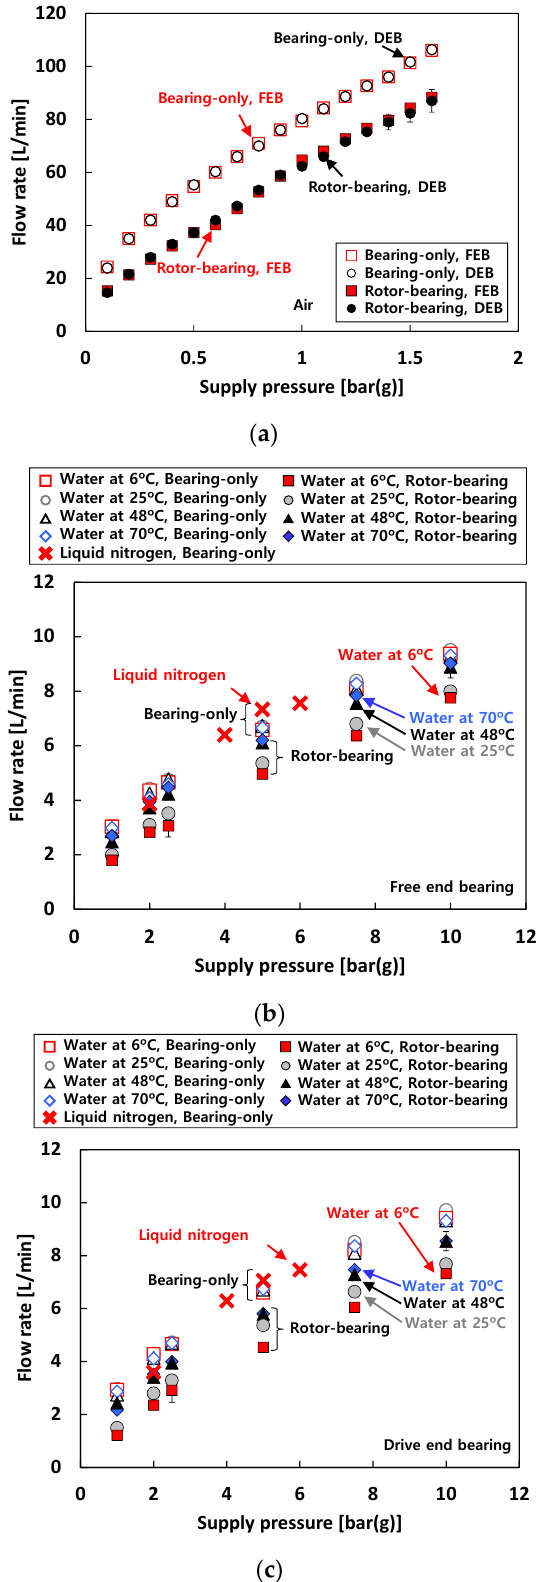
Figure 5. Test cases #1 through #3: recorded flow rate versus supply pressure. ( a ) Test case #1. DEB: drive end bearing. FEB: free end bearing. ( b ) Test cases #2 and #3. Free end bearing. ( c ) Test cases #2 and #3. Drive end bearing.